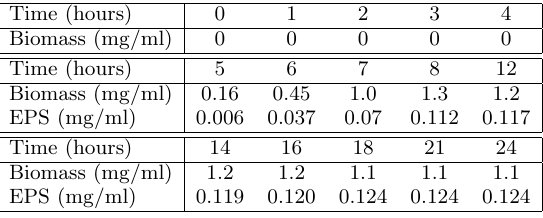
E XPERIMENTAL VALUES OF THE BIOMASS AND